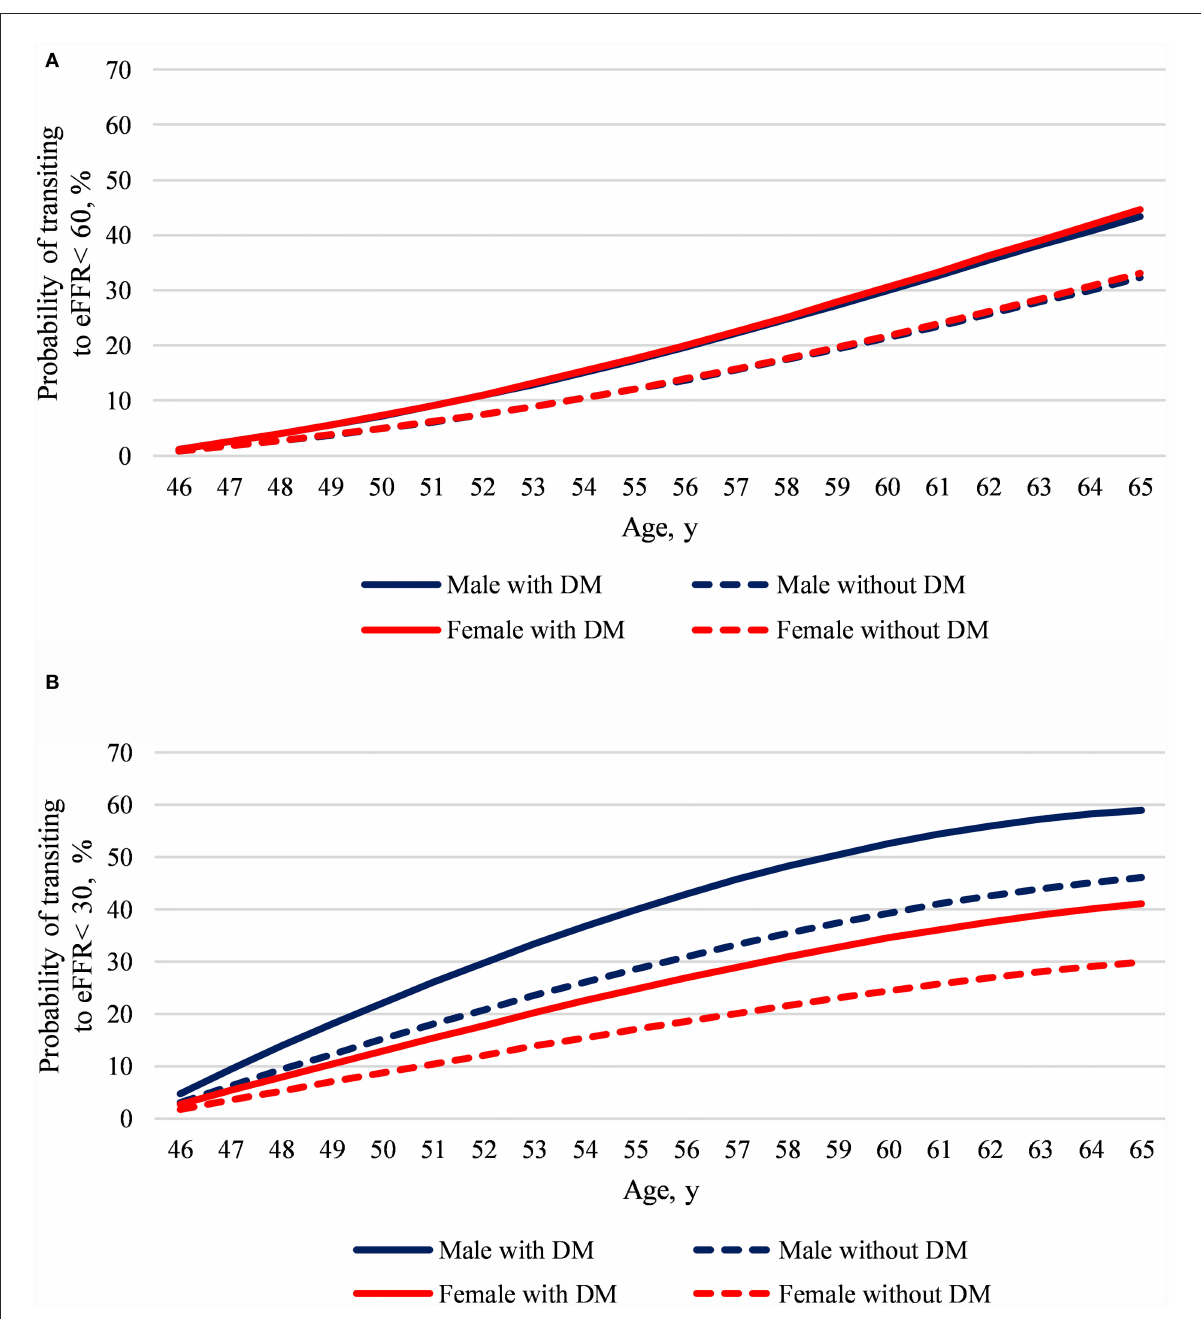
FIGURE3 The model predicted age 46–65 CKD state transition risks at age 45 by sex and diabetes mellitus. (A) Predicted eGFR < 60 transition risk and (B) predicted eGFR < 30 transition risk. We set the reference values for factors other than sex and diabetes in the prediction models, said without coronary artery disease, selected life habitats, metabolic syndrome, and the lowest quartile of all baseline laboratory data. Despite the large study sample size and a median 7-year follow-up, the predicted risk may lose accuracy when it is extrapolated for a long period of time.